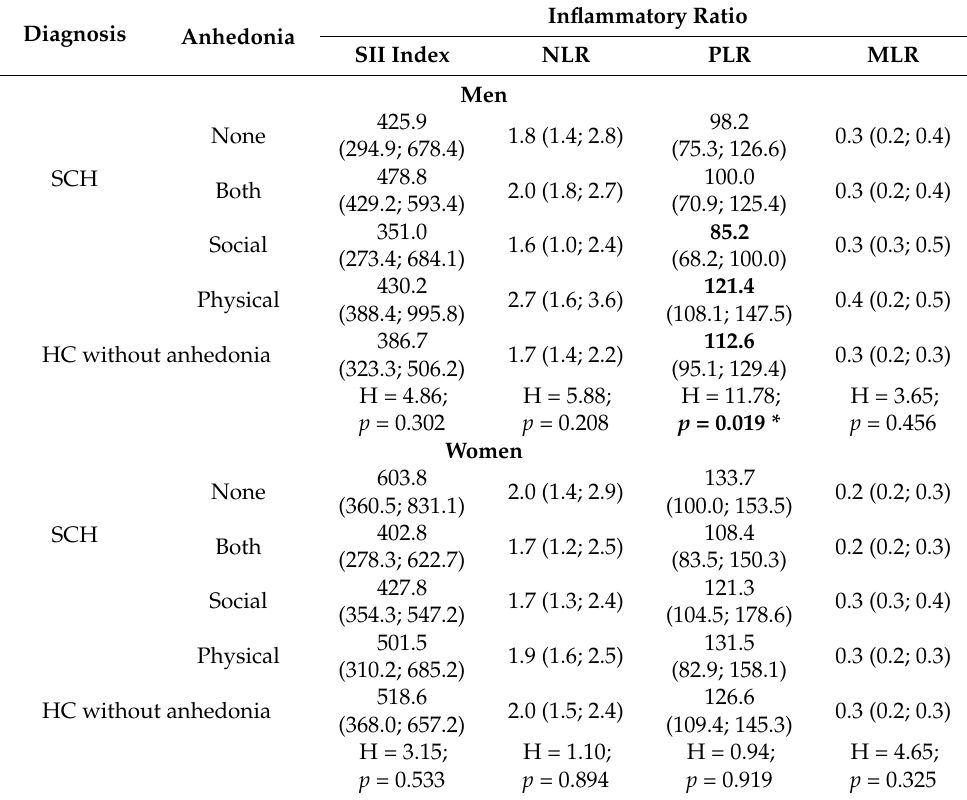
Table 4. Inflammatory ratios compared between patients with SCZ, with or without anhedonia, and healthy control subjects. Data are expressed as median (Q1;